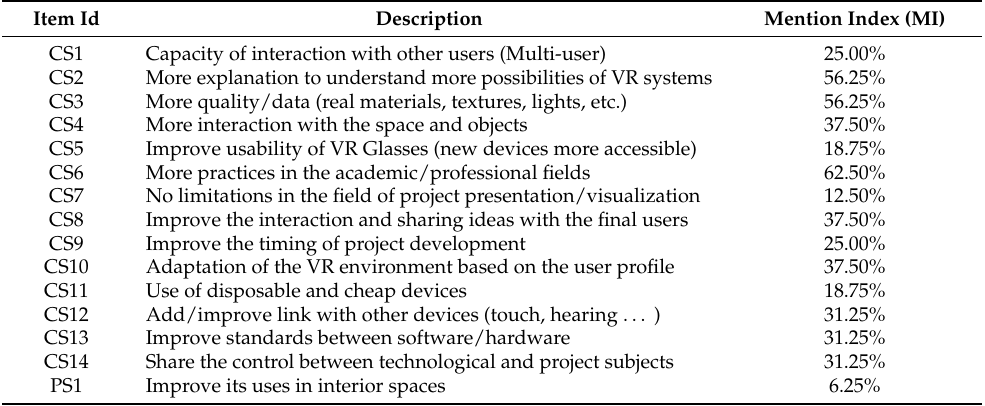
Table 7. Common and particular solutions and improvements for positive and negative elements were